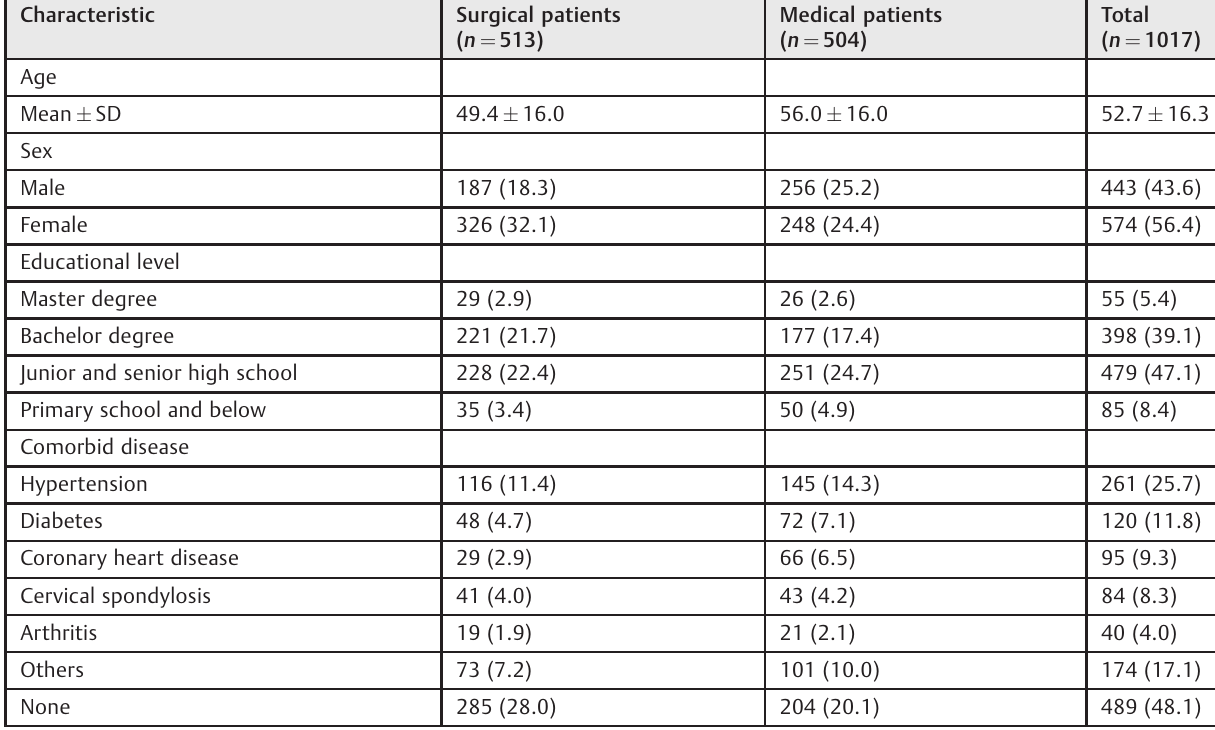
Table 1 Demographic information of the patients ( n ¼ 1,017) Characteristic